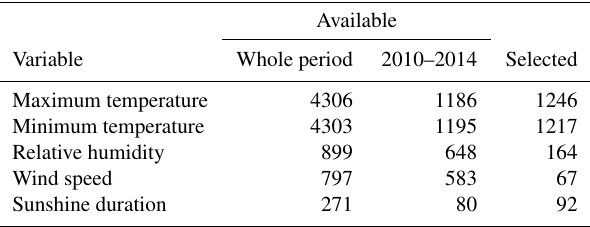
Table 1. Number of weather stations per variable.